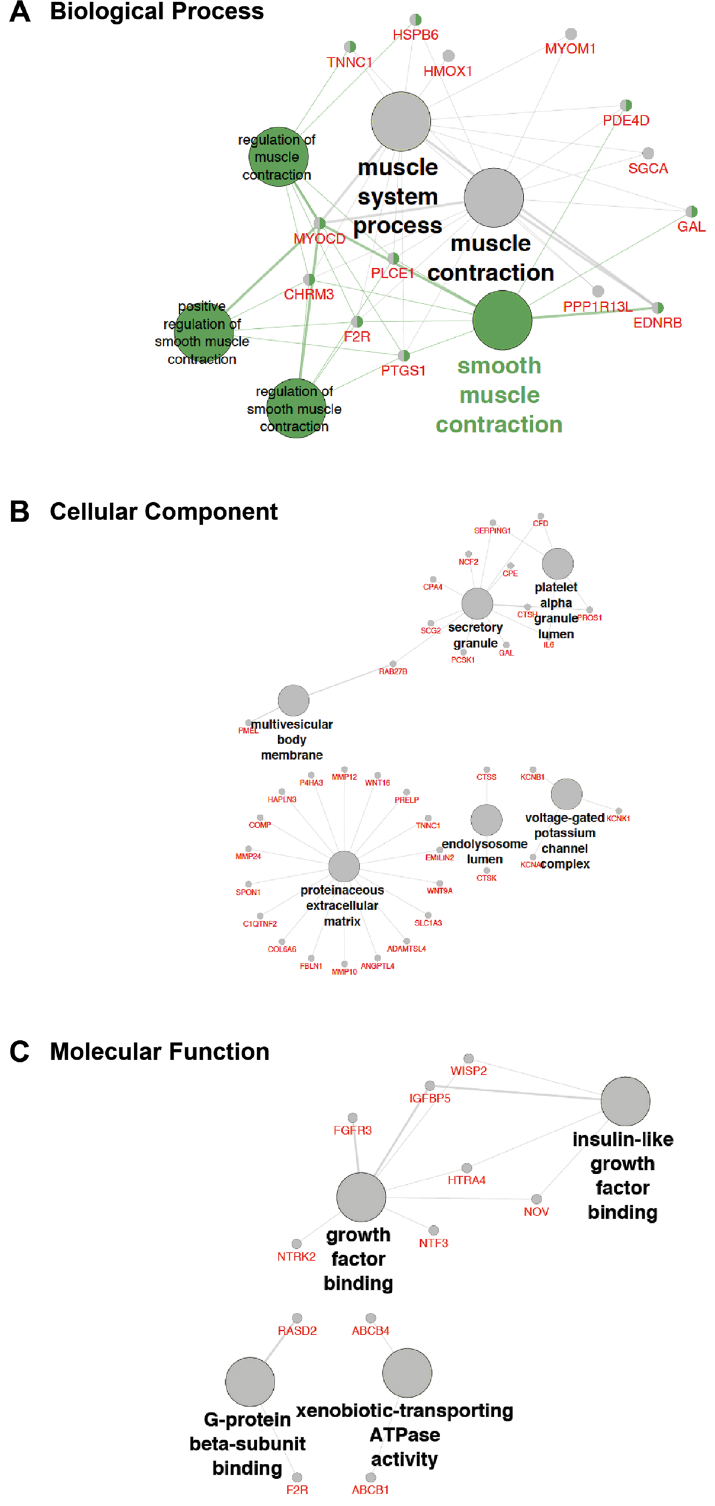
Figure 3. Enriched gene ontology groups: ( A ) Biological process, ( B ) Cellular component, ( C ) Molecular function. The differentially expressed genes list was analysed using ClueGo in Cytoscape. Gene node shading indicates shared associations with each